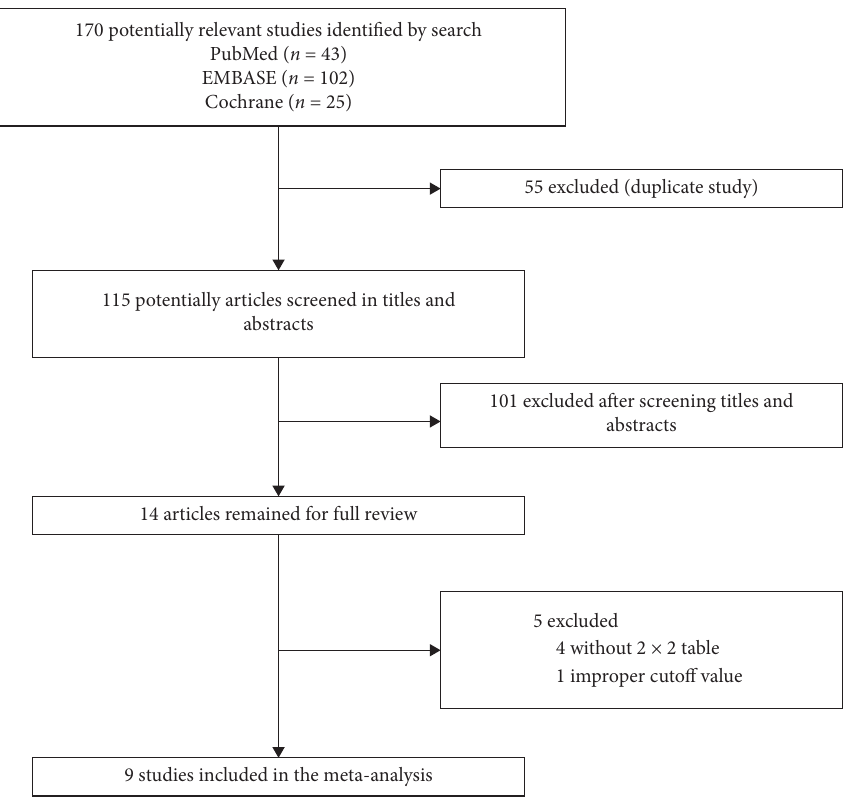
Figure 1: Flow diagram for the identification of eligible